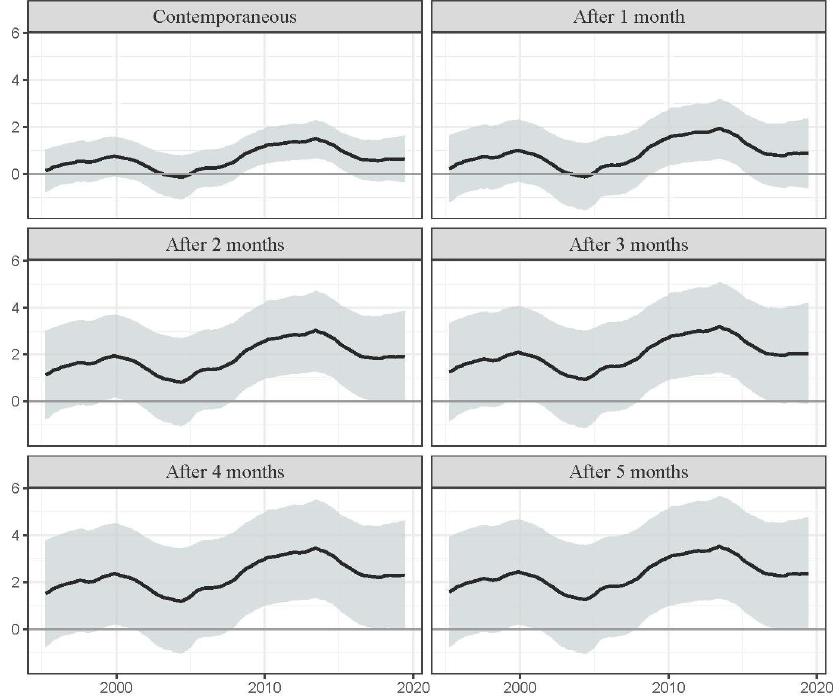
Figure A7. Responses of stock returns to an aggregate demand shock. Note: This figure presents the accumulated responses of stock returns to a one-unit aggregate demand shock in the first five months after the shock (1995:04–2019:06). The solid black line shows the mean while the gray area displays the 16th and 84th percentiles.